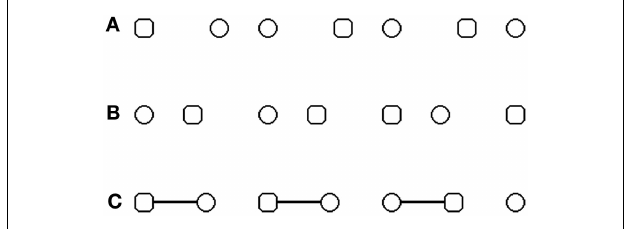
FIGURE 1 | Illustration of the stimuli used to explore visual grouping and re-grouping. (A–C) stimuli used in the original paradigm of Beck and Palmer (2002), with a manipulation of grouping by proximity (A,B) and by connecters (C) . Only two shapes shared the same form and were displayed one beside the other.These two shapes represent the targets. Subjects had to decide if the two targets are two circles or two squares. (A) Example of circle targets belonging to the same pair of figures. (B) Example of square targets belonging to different pairs of figures. (C) Example of circles targets belonging to different pairs of